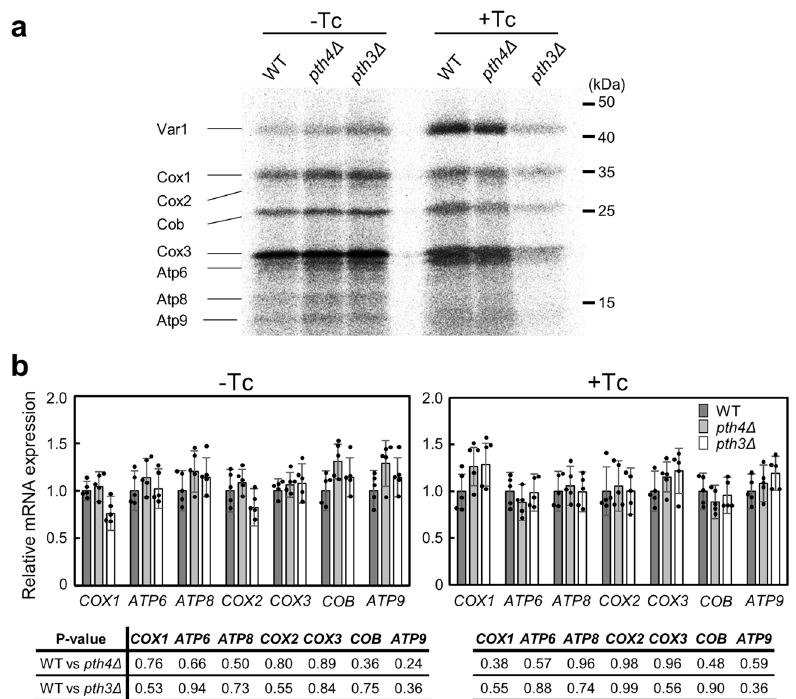
Fig. 4 Effects of the deletion of PTH4 or PTH3 on mitochondrial translation and transcription in the absence or presence of tetracycline. a Mitochondrial translation products synthesized in organelles from the wild type (WT), pth4 Δ , and pth3 Δ grown in YPG media for 24 h in the absence or presence of 500 µ g/mL tetracycline (Tc). Fresh mitochondria isolated from each strain were incubated with [ 35 S]methionine in translational buffer. Mitochondrial lysates were analyzed by 16% SDS-PAGE and autoradiography. The corresponding Coomassie blue-stained gels are shown in Supplementary Fig. 7a. Quantitative comparison of mitochondrial translation products is shown in Supplementary Fig. 7b. b qPCR data of all mtDNA protein-coding genes, except for VAR1 , from total RNAs extracted from the three strains in the absence or presence of 500 µ g/mL Tc. Data are shown as the mean ± standard deviation of fi ve independent experiments. P values are shown in the tables. There were no statistical signi fi cant differences between the wild type and each mutant in the absence or presence of Tc (Student ’ s t test, p > 0.1). The mRNA expression of VAR1 was described in the